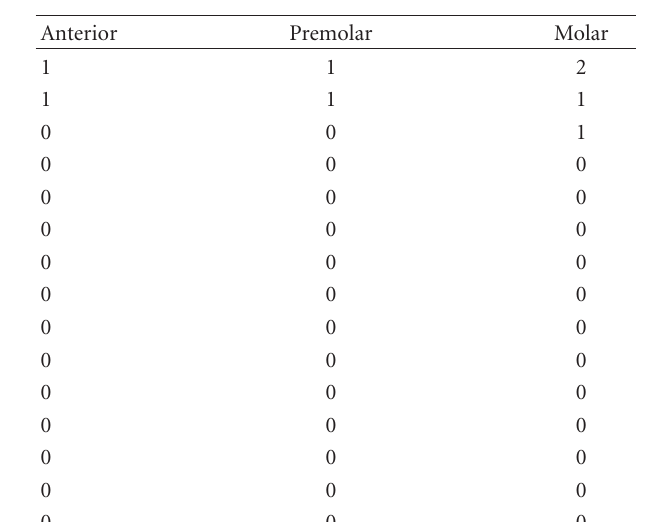
Table 1: Pain scores that were obtained during teeth extractions from three di ff erent maxillary